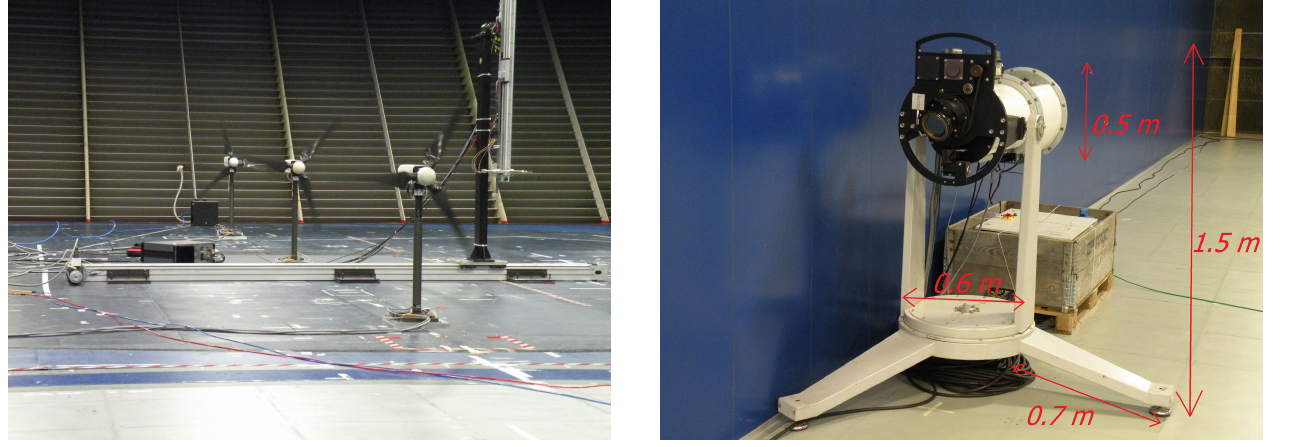
Figure 1. Model wind turbines in operation in the wind tunnel. Figure 2. One of the two WindScanner lidars inside the wind tun-